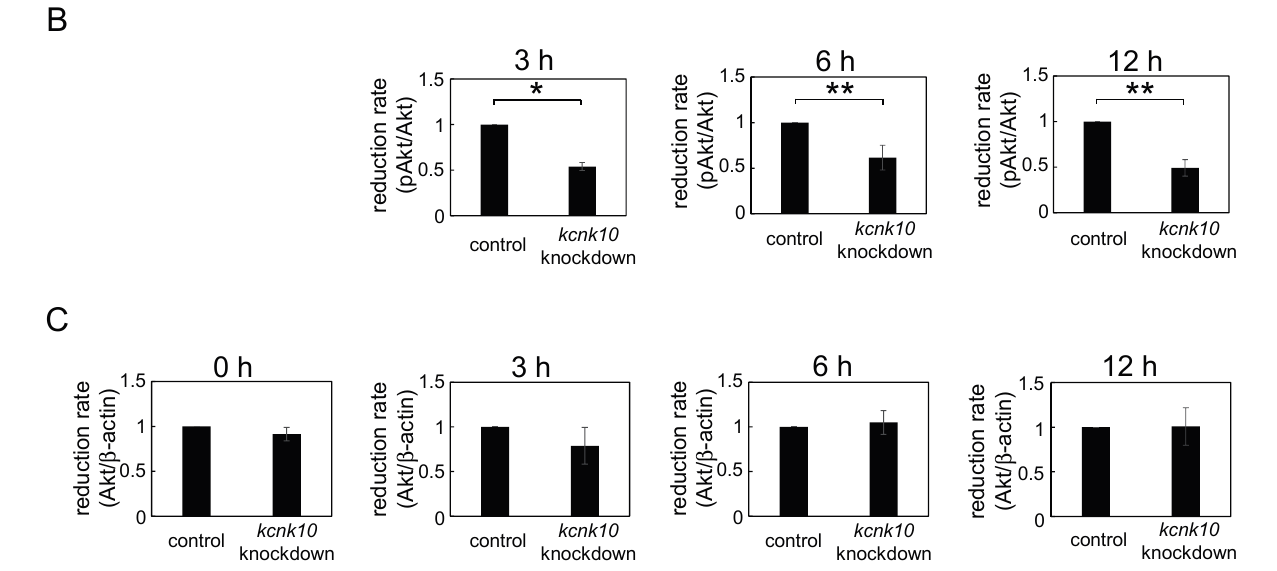
Figure 5. Effect of kcnk10 knockdown on insulin-induced Akt phosphorylation. Kcnk10 knockdown cells or control cells were starved for 4 h and treated with 10 nM